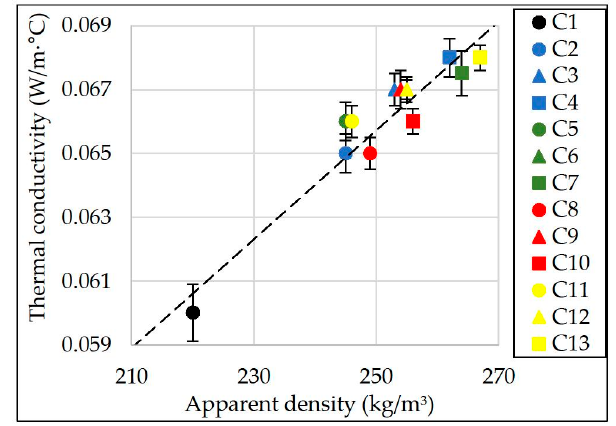
Figure 7. Thermal conductivity of samples.